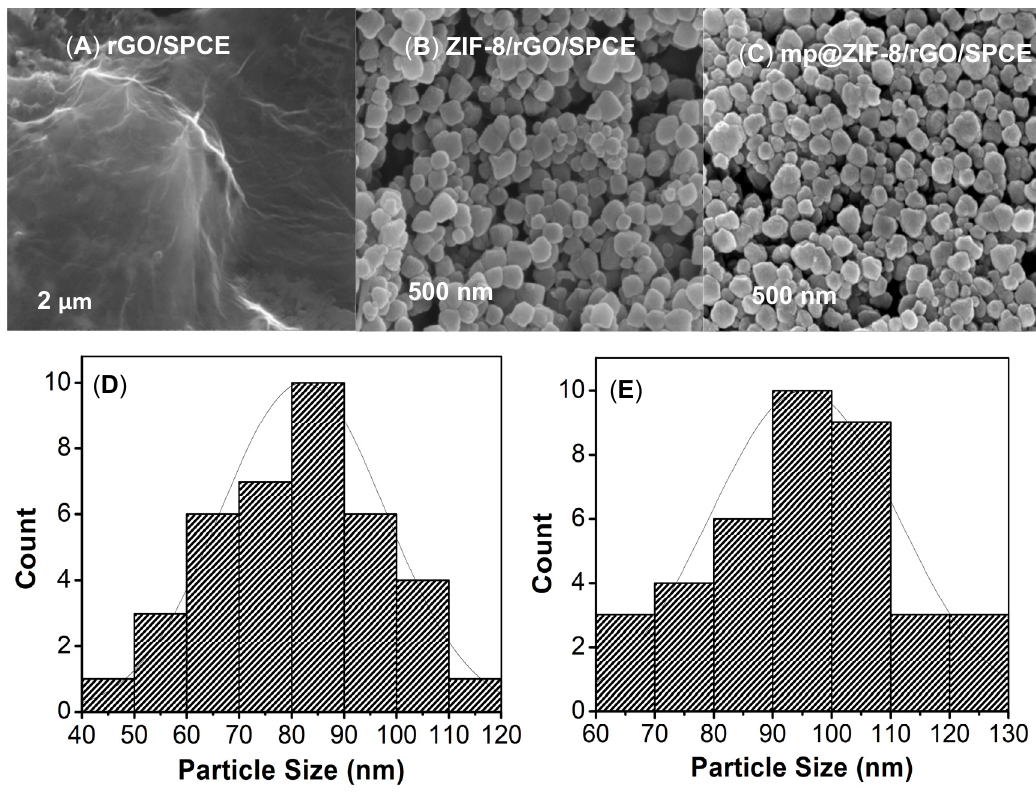
Figure 3. FESEM images display respective ( A ) rGO/SPCE, ( B ) ZIF-8/rGO/SPCE, and ( C ) mp20@ZIF-8/rGO/SPCE morphologies at 100kx magnification and histogram on particles size distribution of ( D ) ZIF-8/rGO/SPCE and ( E ) mp20@ZIF-8/rGO/SPCE .